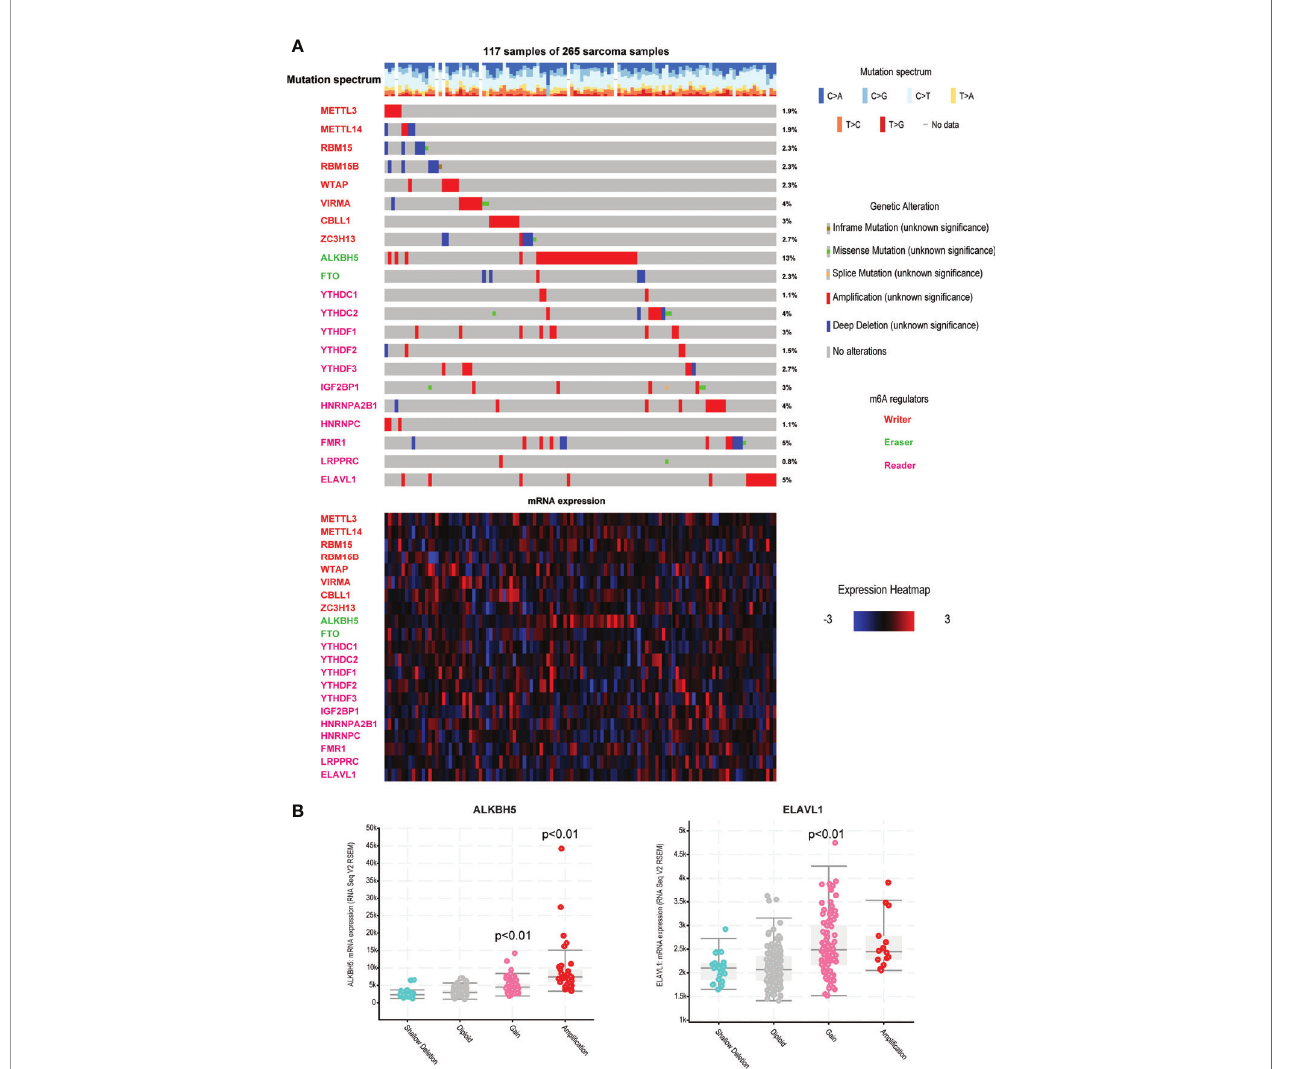
FIGURE 1 | Landscape of genetic and expression variation of m6A regulators in TCGA sarcoma. (A) The mutation frequency of 21 m6A regulators in 265 patients with sarcoma in TCGA. Each column represented individual patients. The number on the right indicated the mutation frequency in each regulator. The lower heatmap represents m6A regulators ’ expression in sarcoma. Three types of regulators were labeled in different colors. (B) The impacts of different genome alterations on gene expression of ALKBH5 and ELAVL1. P <0.01 represents the expression levels were signi fi cantly changed in alteration group vs. diploid